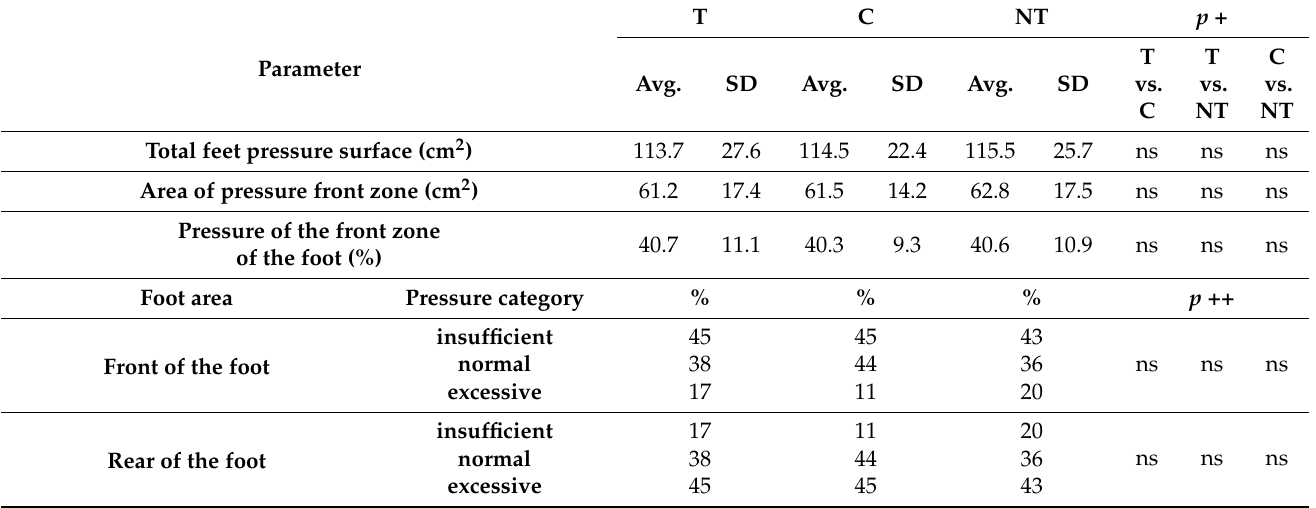
Table 4. Foot pressure surface parameters and percentage of feet with a speci fi c pressure category